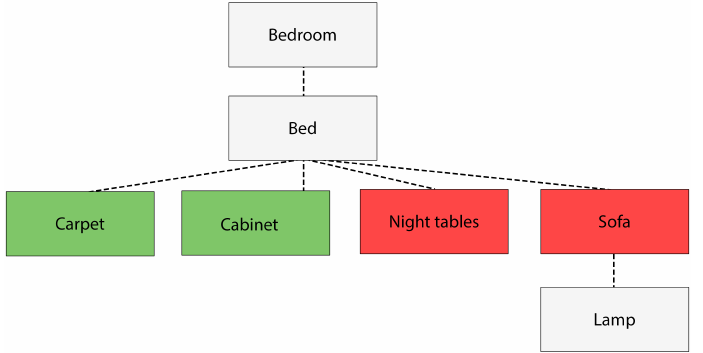
Figure 2. Hierarchical tree of procedural rules. The rules on the third level of the tree belong all to one concurrency group. However, the red rules cannot coexist together; therefore, they are also in an avoidance group. The red rules can still be executed concurrently with all green